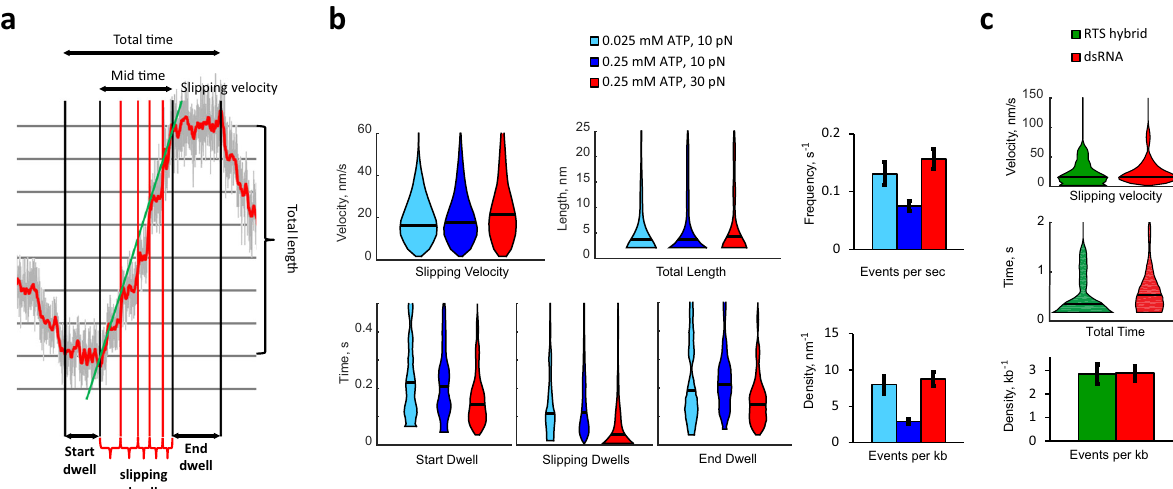
Fig. 3 Reverse-translocation dynamics. a An individual reverse-translocation event is divided into three sections to differentiate the fi rst and last dwell from the dwells during burst-sized slipping (slipping dwells). b Violin plots and bar graphs of select aspects of the reverse-translocation events on dsRNA under different [ATP] and opposing force are shown. Data are from n = 57, 85, and 83 reverse-translocation events for 0.025 mM [ATP] 10 pN, 0.25 mM [ATP] 10 pN, and 0.25 mM [ATP] 30 pN, respectively. c Violin plots and bar graphs showing the differences of select statistics when the substrate is the RTS hybrid compared to dsRNA. Data are from n = 21, 85 reverse-translocation events for RTS hybrid and dsRNA, respectively. As the total length is equal to the slipping velocity times, the mid-time, the trend in total length is identical to that of the mid-time graph, as the slipping velocities for RTS hybrid and dsRNA are the same. [ATP] is 0.25 mM and the opposing force is 10 pN. For b and c , horizontal black lines on the violins are the median of the corresponding distribution and errors on bar graphs are